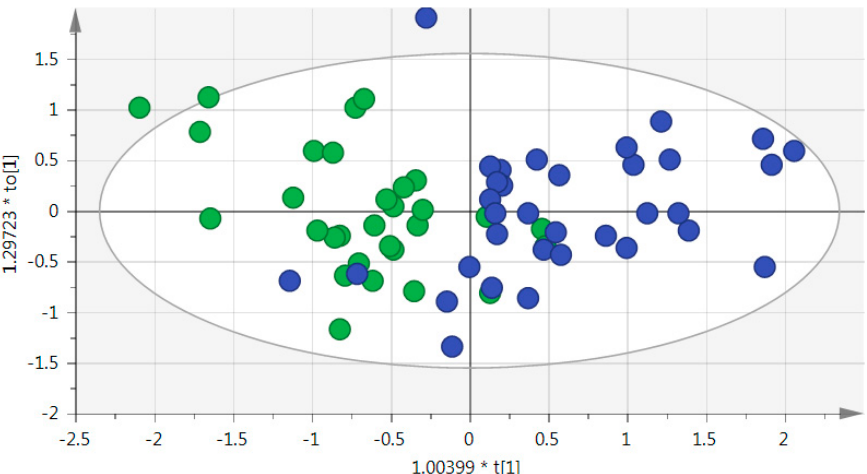
Figure 1. Score plot for the orthogonal partial least squares-discriminant analysis (OPLS-DA) model based on the 8 most significant metabolites from the S-plot. Control samples are represented by green circles; POAG (primary open-angle glaucoma) plasma is represented by blue circles. Goodness of fit (R2)Y (cum) = 0.5, goodness of prediction (Q2) (cum) = 0.4; coefficient of variation (CV) Anova p -value = 1.8042 × 10 − 5 ; Intercepts from the permutation test permR2 = 0.0355, permQ2 = − 0.101.